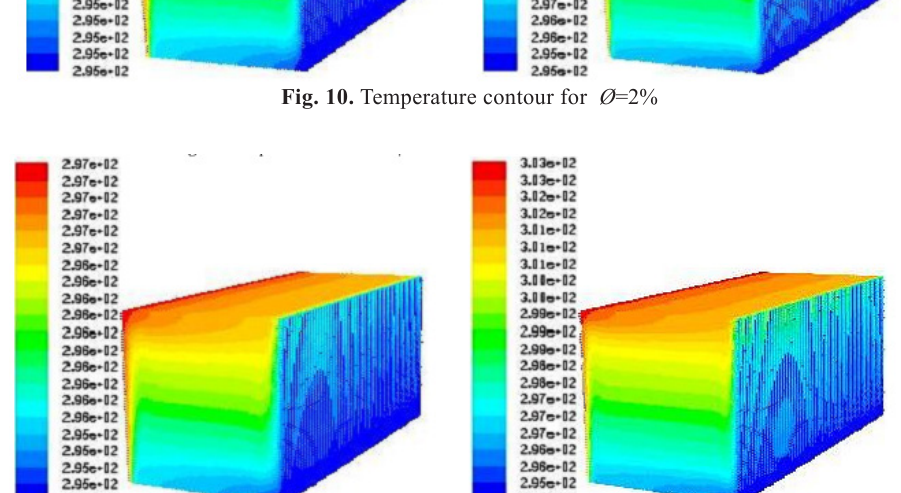
Fig. 11. Temperature contour for Ø